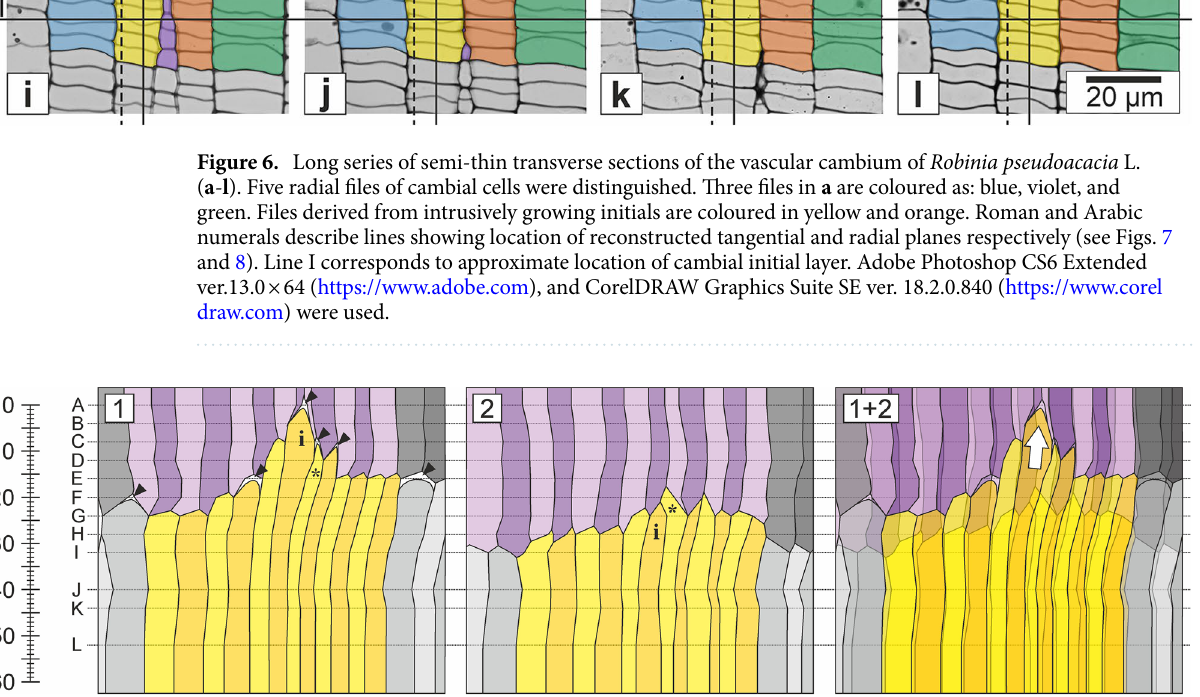
Figure 7. Anatomical reconstructions of radial planes of the vascular cambium of Robinia pseudoacacia L. Scale on the left is expressed in μm. ( 1 ) Reconstruction of radial plane 1 shown in Fig. 6. ( 2 ) Reconstruction of radial plane 2 shown in Fig. 6. ( 1 + 2 ) Superposed radial reconstructions 1 and 2. i—cell considered as cambial initial in plane 1. *—cell considered as cambial initial in plane 2. Black arrowheads indicate microspaces, which are usually formed prior to intrusive growth of a cell. White arrow indicates the direction of intrusive elongation of cell i. CorelDRAW Graphics Suite SE ver. 18.2.0.840 (https:// www. corel draw. com) was